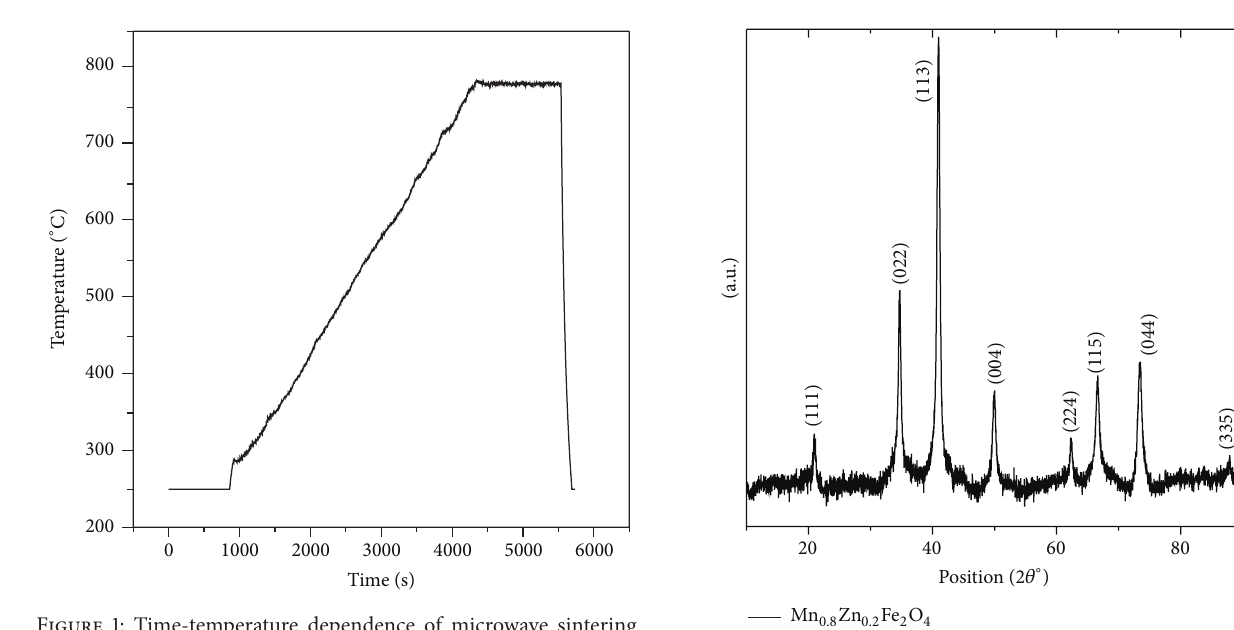
Figure 1: Time-temperature dependence of microwave sintering process.